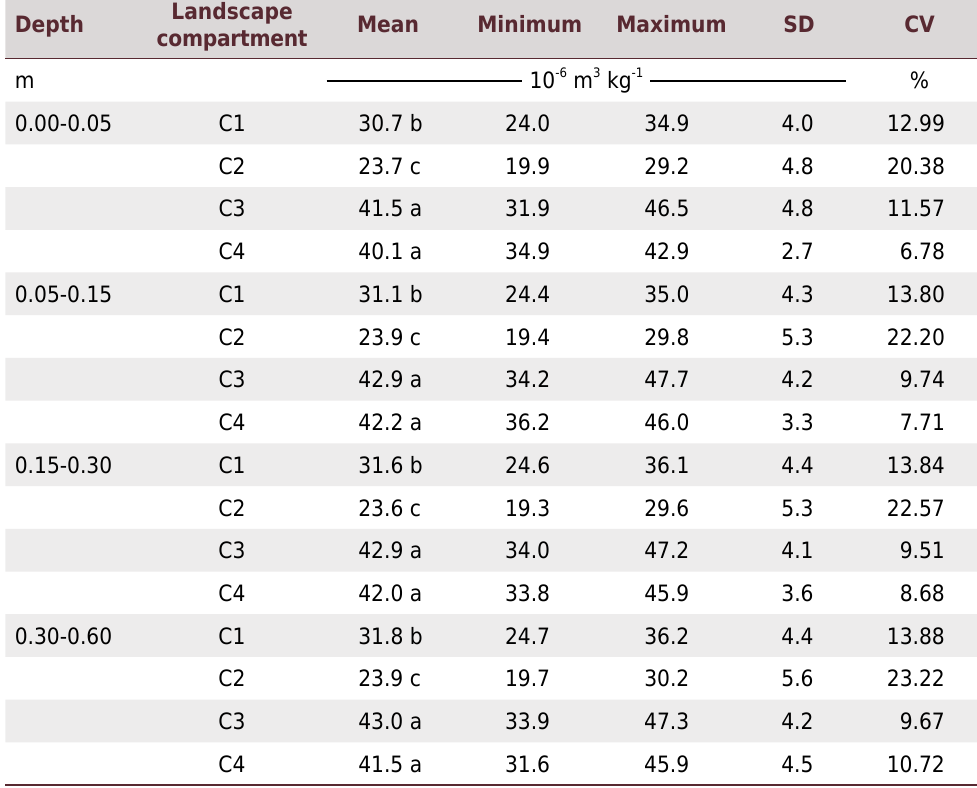
Table 3. Descriptive statistics magnetic susceptibility in the four compartments Landscape Depth